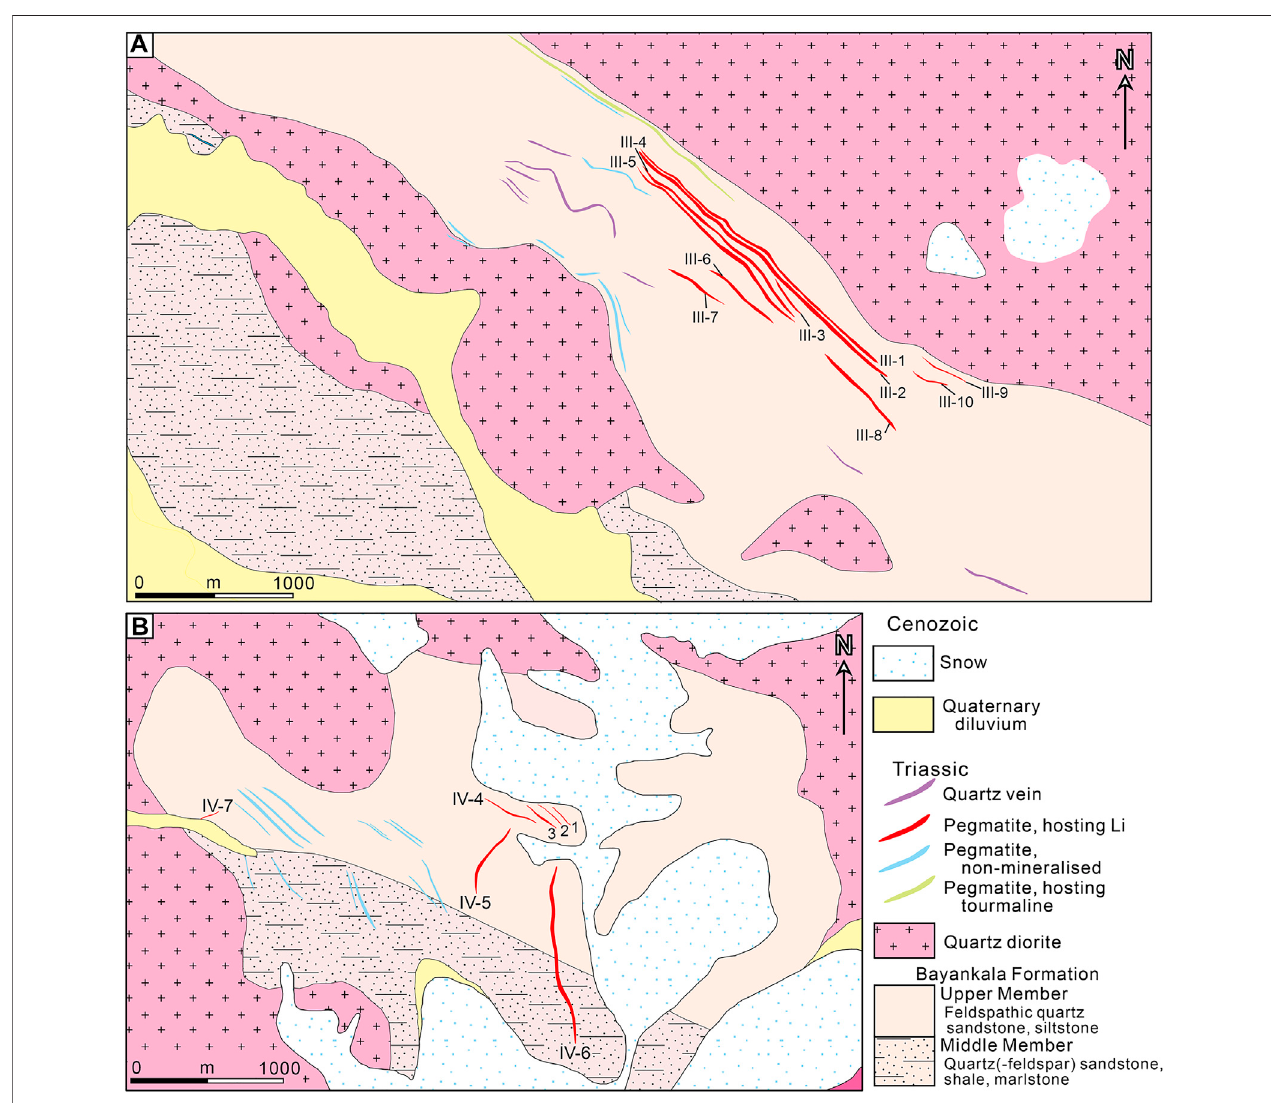
FIGURE 8 | Geological maps of: (A) the South Fulugou 1# Li deposit; and (B) the South Fulugou 2# Li deposit.